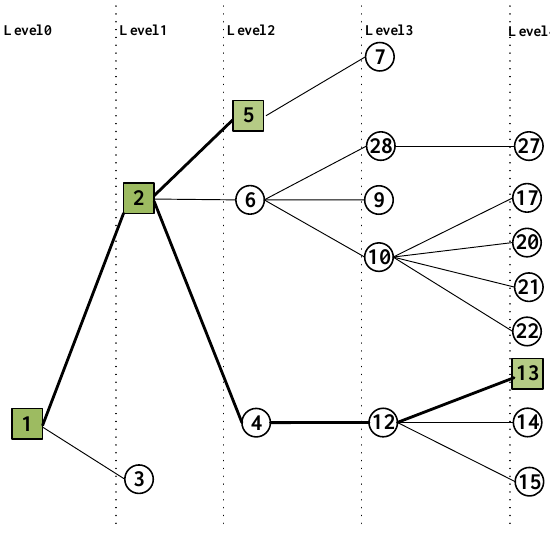
Figure 4. The tree associated with the coherent generator Set 1, where generator Node 1 is the root node and the critical subgraph is highlighted by bold